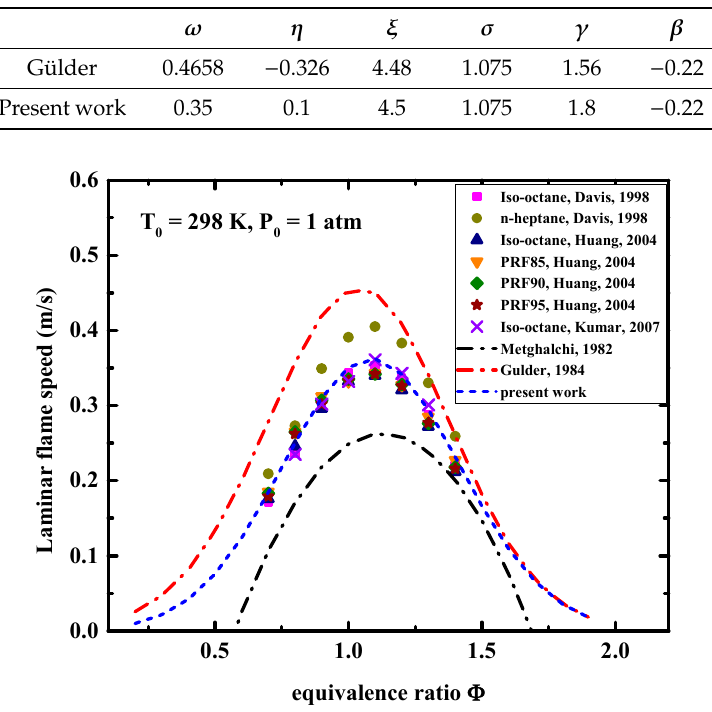
Figure 1. Comparison of the fitting curves and experimental data of laminar flame speed.